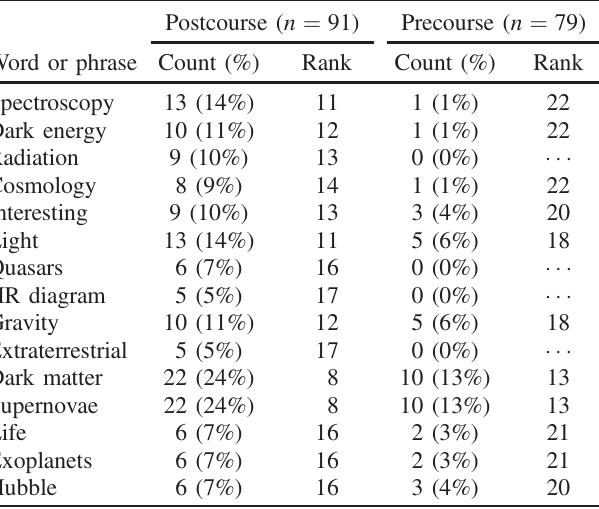
TABLE IV. Words or phrases students associated with astronomy, both pre- and postcourse (only the words mentioned by at least 10% of the class are shown). In each case, the words are listed by the total number of students whose responses contained the word (or an equivalent). Words with asterisks appear in only one column, i.e., either pre- or postcourse only.